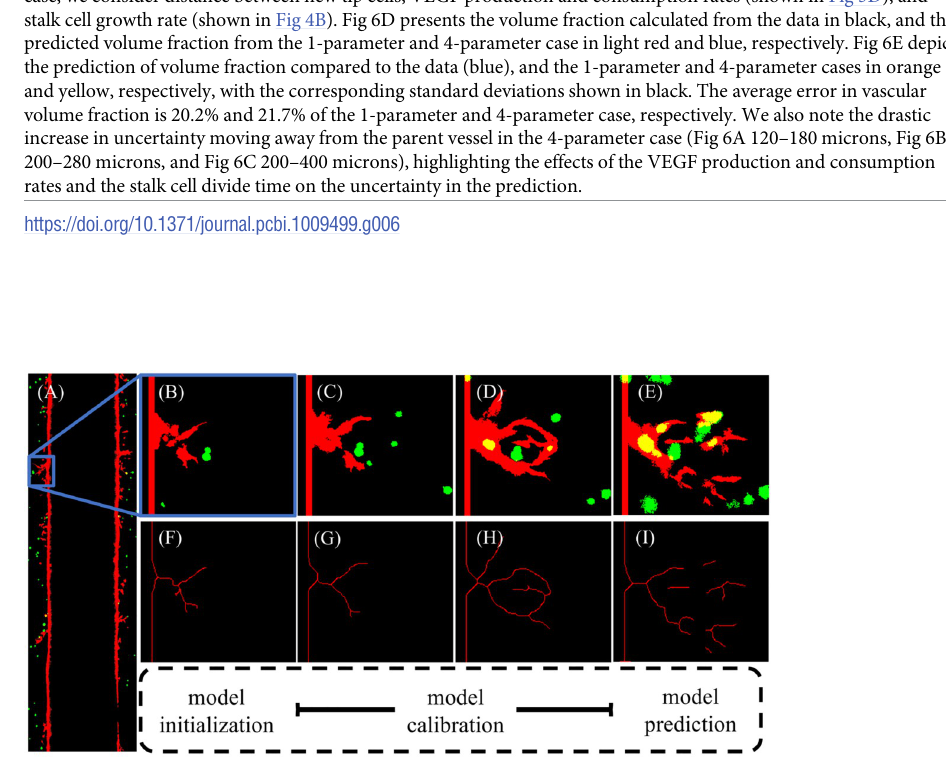
Fig 7. Vascular regions for local calibration. Fig 7A shows a RBG binarized image of vascular structure of day 3 in the microfluidic platform. Fig 7B-E depict a specific local region segmented over time (blue box in Fig 7A) with vessels shown in red and tumor cells shown in green from days 3, 5, 7, and 9. Fig 7F-I show the corresponding centerline segmentation of Fig 7B-C, computed from a parallel thinning algorithm. The local analysis flowchart is shown by model initialization using the day 3 centerline, model calibration utilizing days 5 and 7, and model prediction of the centerline from day 9.